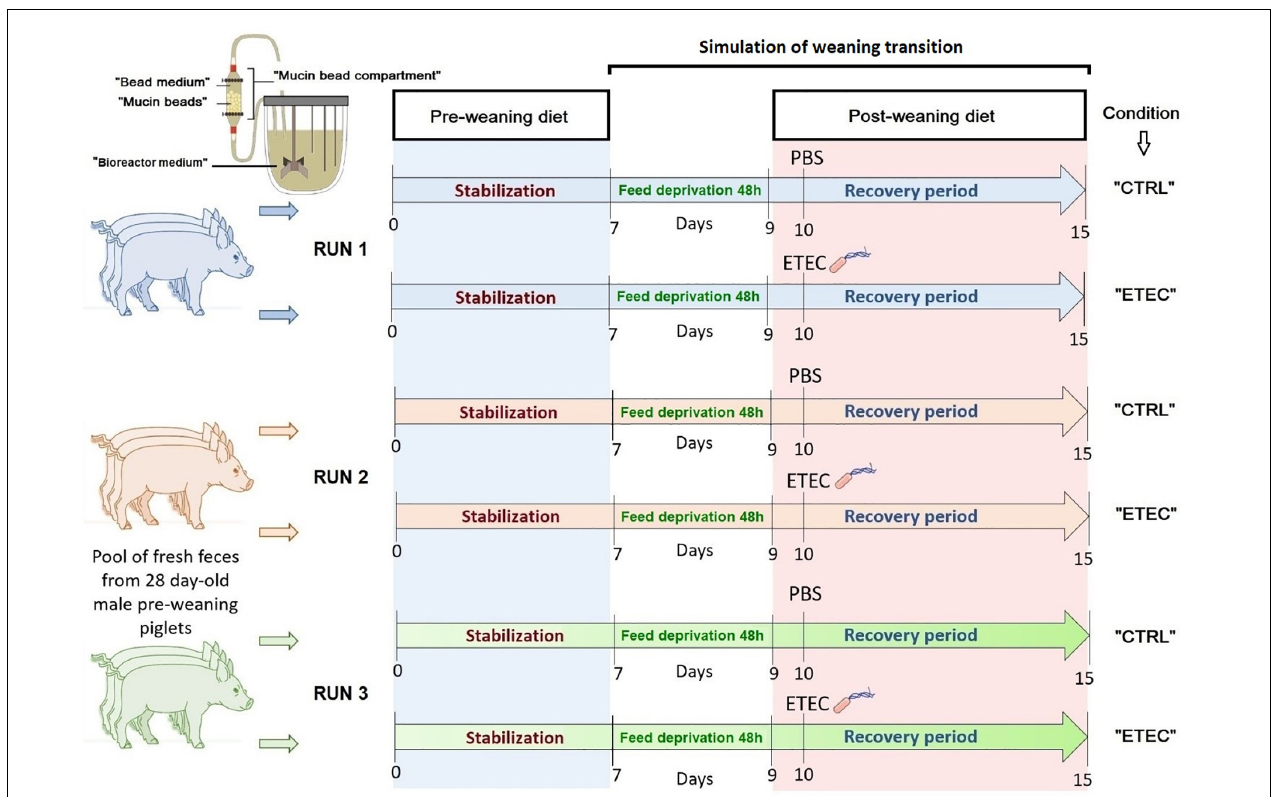
FIGURE 1 | Experimental design of the in vitro fermentations and denomination of the conditions studied in the MPigut-IVM.